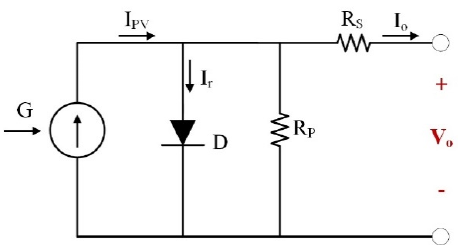
Figure 4. Equivalent circuit of single diode model for PV.